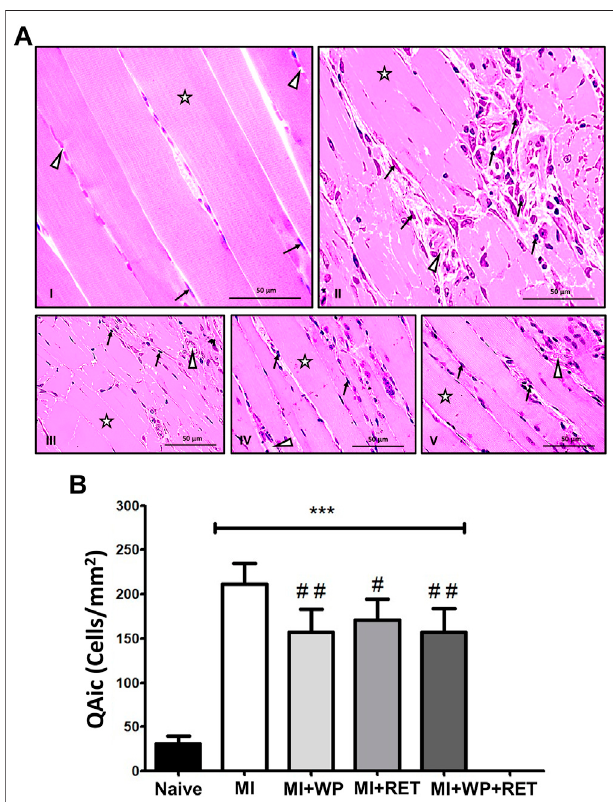
FIGURE 5 | Effect of the resistance exercise training (RET) and whey protein supplementation (WP) on the gastrocnemius muscle interstitial cellularityinthegastrocnemiusmuscleafterthe2ndweekofmuscleinjury(MI). (A) Representativehistologicalaspectofthegastrocnemiusmusclefrom control and treated animals (star: skeletal myocyte, arrow: nuclei of interstitial cells, arrowhead: blood vessel). Groups: I (cid:1) naive, II (cid:1) MI, III (cid:1) MI underwent WP,IV (cid:1) MIunderwentRET,andV (cid:1) MIunderwentWPplusRET. (B) Number density of interstitial cells (QAic) in the gastrocnemius muscles of rats underwent RET, WP, and RET plus WP. Data are expressed as the mean ± S.E.M. of six animals per group. *** p < 0.001 indicates the statistical signi fi cance compared to the naïve group; # p < 0.05 and ## p < 0.01 indicate statistical signi fi cance compared to the MI group. One-way ANOVA was followed by the Bonferroni post hoc test.